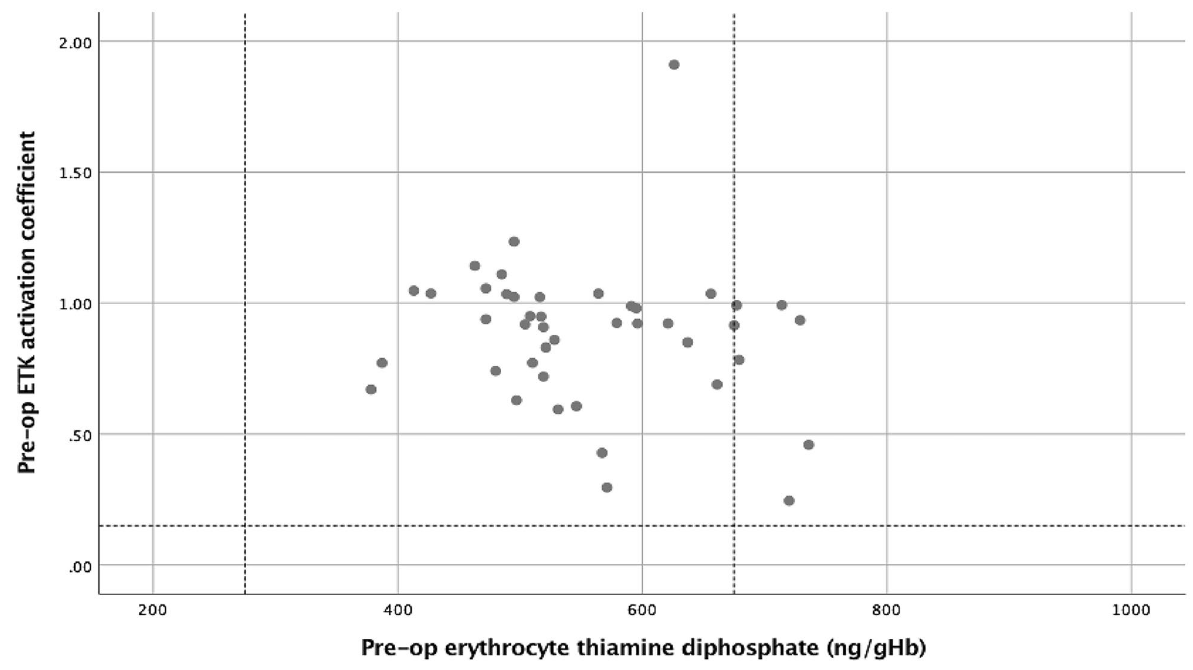
Figure 1. The relationship between pre-operative erythrocyte thiamine diphosphate and erythrocyte transketolase activation coefficient (ETK activation coefficient: erythrocyte transketolase activation coefficient).